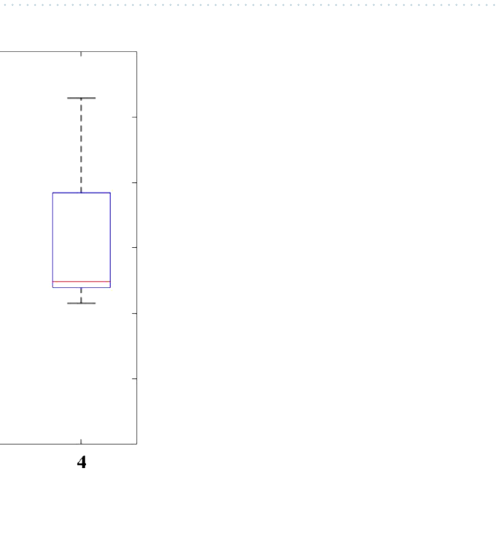
Figure 2. Initial flow rate ( q i )